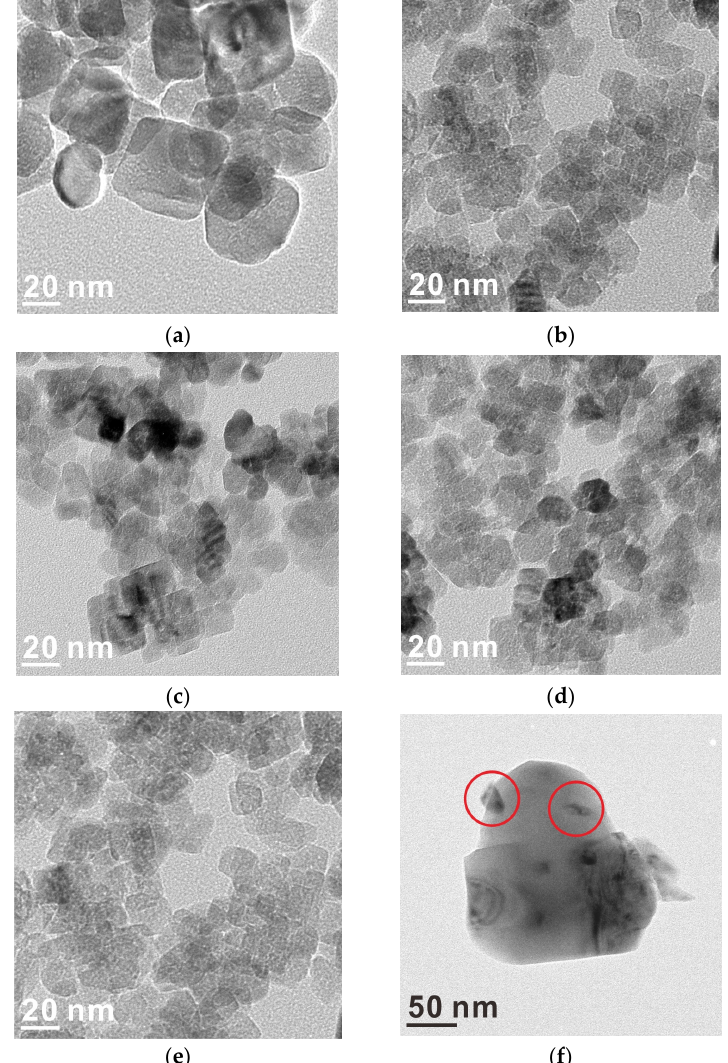
Figure 3. TEM image of Ru x TiO 2 , ( a ) TiO 2 ; ( b ) Ru 0.01 TiO 2 ; ( c ) Ru 0.03 TiO 2 ; ( d ) Ru 0.05 TiO 2 ; ( e ) Ru 0.07 TiO 2 ; and ( f ) A ‐ Ru 0.07 TiO 2 . Red circles: RuO 2 .